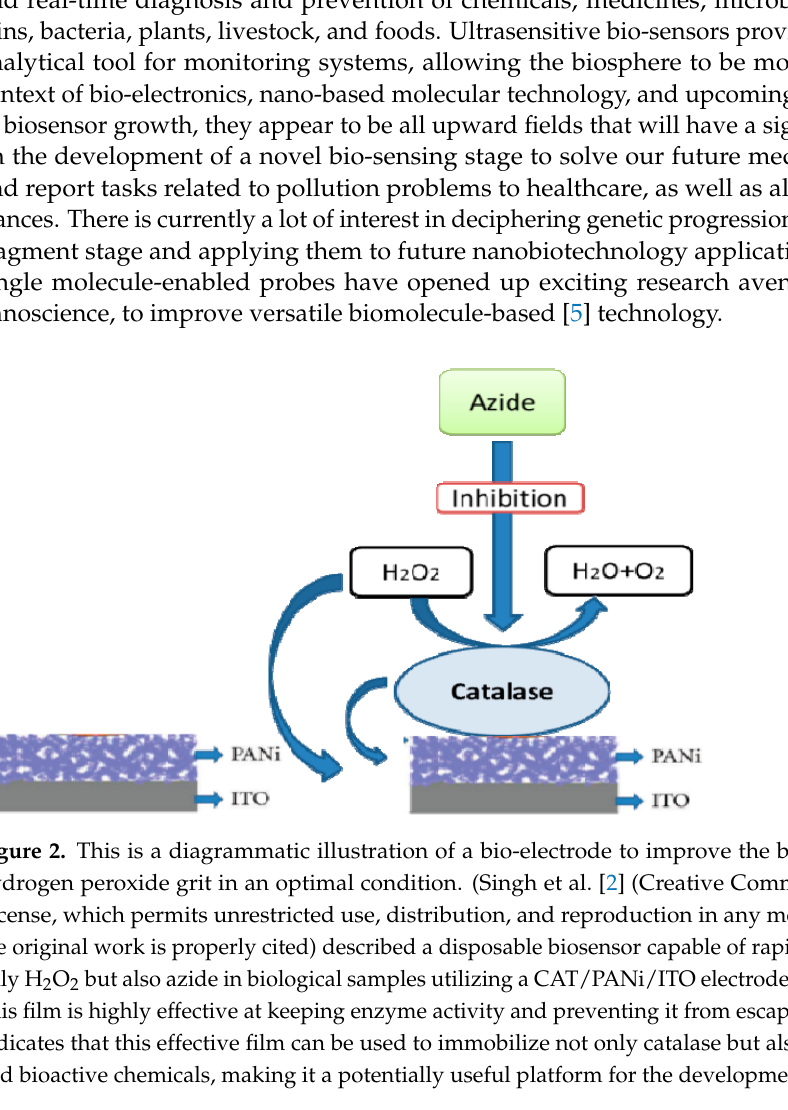
Figure 1. Indicates the fundamental theory of biosensor.